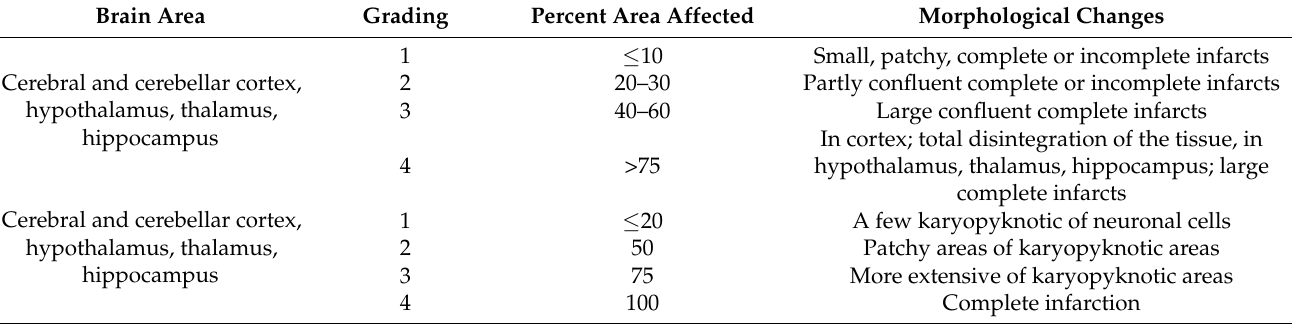
Table 1. The neuropathologic